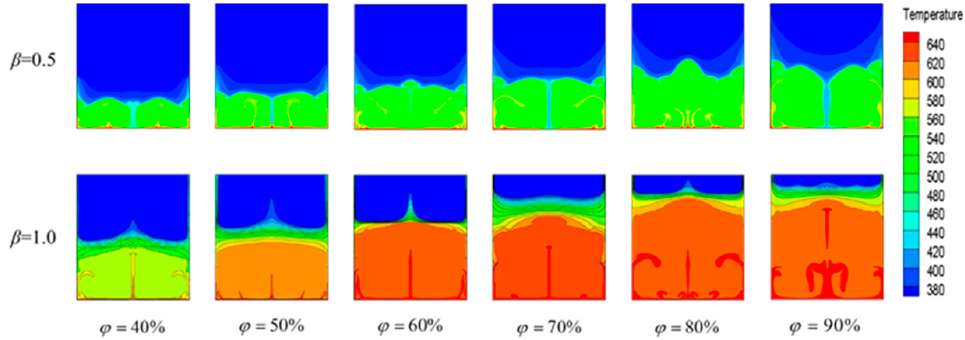
Figure 7. Temperature fields at different φ values.